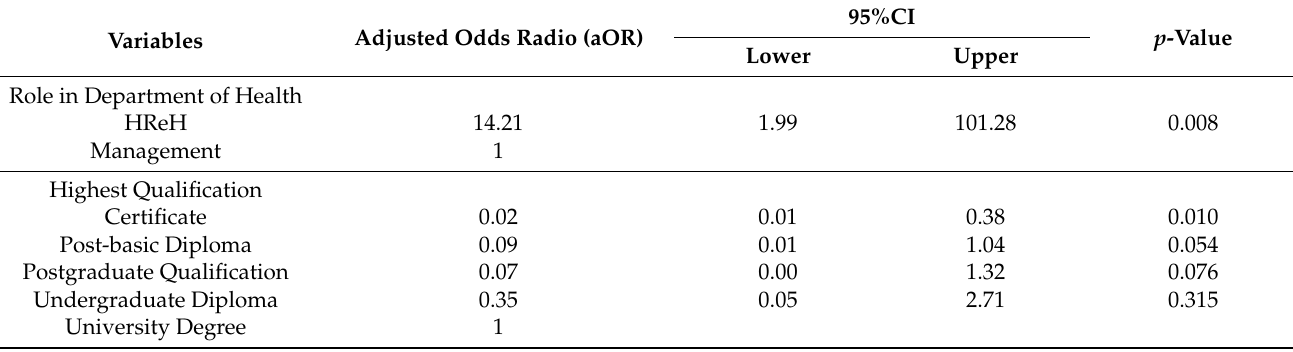
Table 3. Logistic regression output for having good